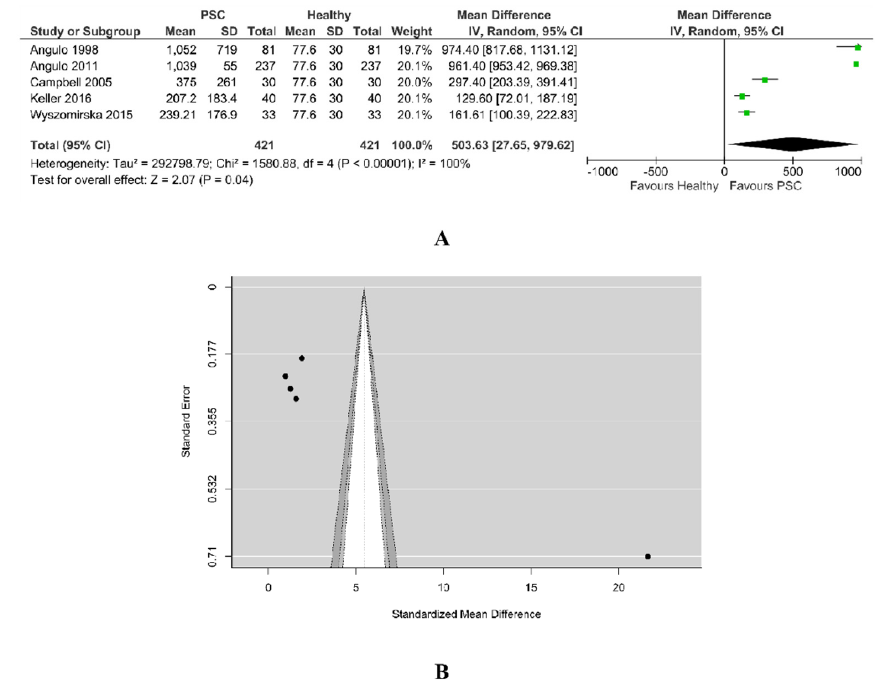
Figure 10. ( A ) Forest plot assuming a random-effects model for alkaline phosphatase PSC vs. Healthy. ( B ) Funnel plot for publication bias assessment for alkaline phosphatase in PSC patients vs. Healthy [18,19,29,32,34].